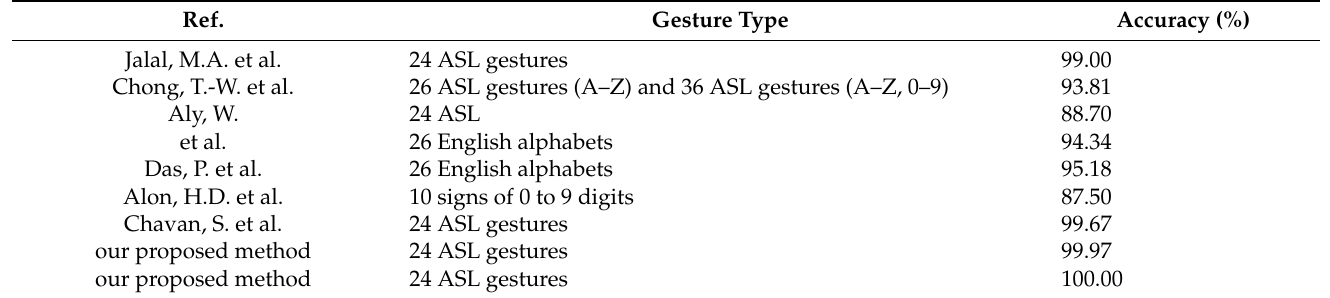
Table 5. Performance comparison of the proposed hand gesture recognition with state-of-the-art.